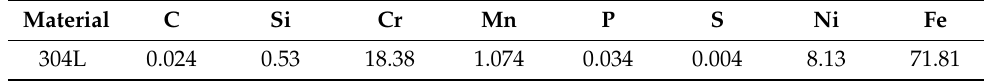
Table 1. 304L stainless steel chemical composition/wt.%.